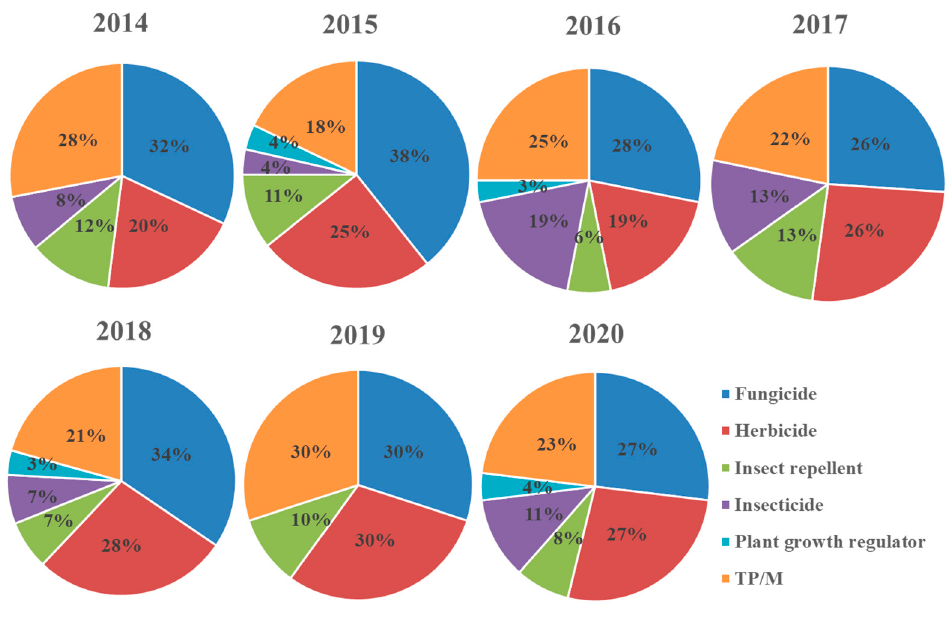
Figure 1. Detection frequencies of pesticide classes in influent wastewater sampled in Athens from